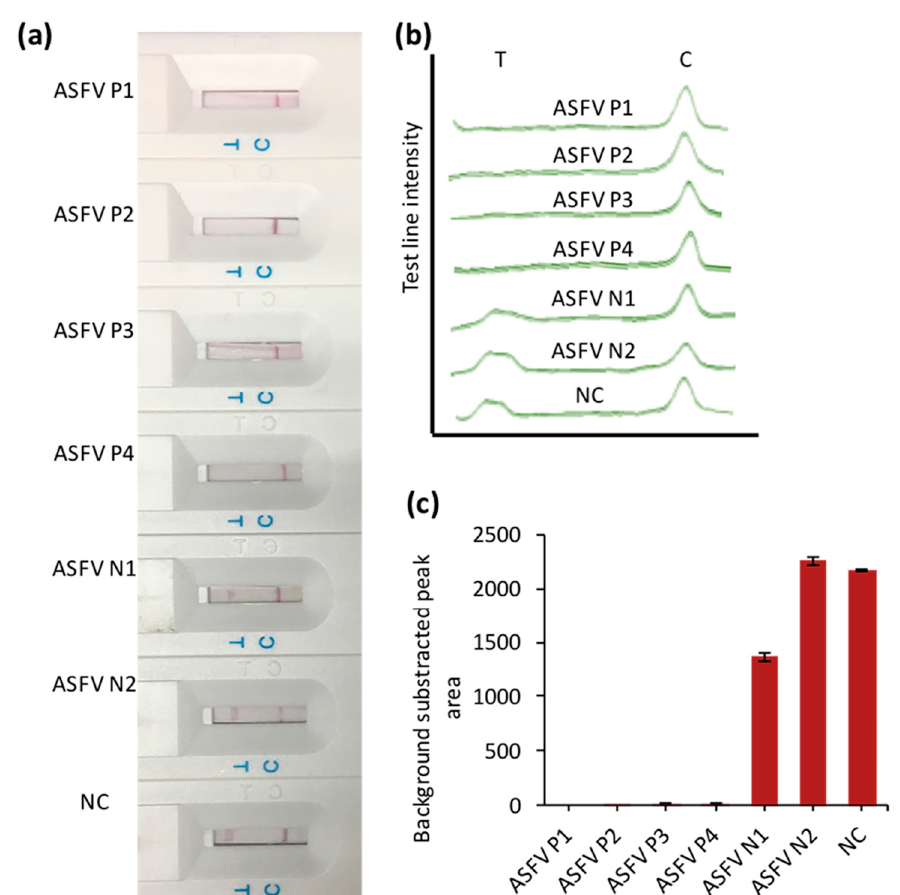
Figure 6. Clinical samples testing. ( a ) LFB responses for the positive (ASFV P1–P4) and negative (ASFV N1–N2) clinical samples. ( b ) Test and control line signal intensities. ( c ) Bar chart of the LFB test lines in ( a , b ). NC stands for negative control (water).